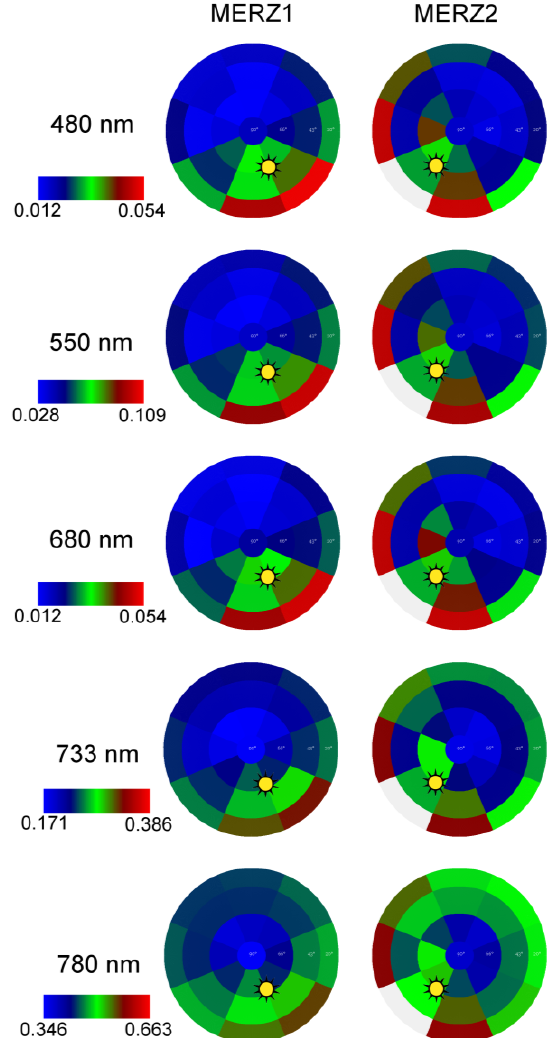
Figure 10. Reflection of MERZ1 and MERZ2 for 5 wavelengths of interest. The color legend of reflection for each horizontal pair was scaled to the occurring reflectance wavelength range . Figure 5 details the angular arrangement depicted here. Waypoint (20°, 225°) is missing in MERZ2 and coded in this graphic in